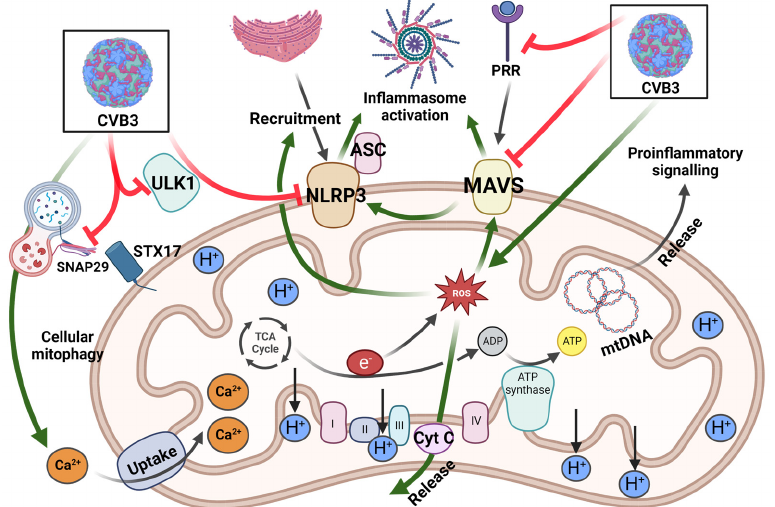
Figure 2. The effects of CVB3 on mitochondrial function. Mitochondrial antiviral signaling protein MAVS and mitochondria recruited ULK1 are key factors during viral recognition and mitophagy initiation, respectively. CVB3 inhibits autophagy initiation and lysosomal fusion by targeting ULK1 and SNAP29/STX17, respectively. ETC-facilitated ATP synthesis involves complex I, II, III, cyt c, and complex VI for coupled reduction-oxidation reactions. MAVS, NLRP3, and ASC all promote inflammasome activation for downstream inflammatory signaling pathways. CVB3 promotes ROS generation, resulting in cyt c release, NLRP3 mitochondrial localization, and induced MAVS expres- sion. Furthermore, viral proteases cause MAVS and ULK1 cleavage, along with enhanced Ca2+ in- flux.